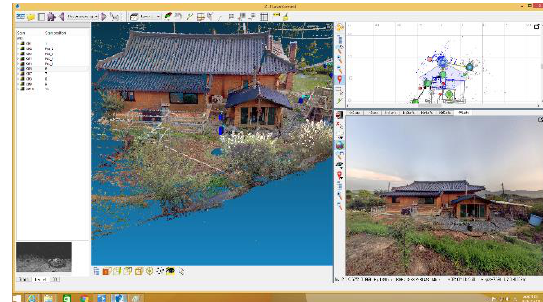
Figure 7. 3D model generated at Station 4 and photo image